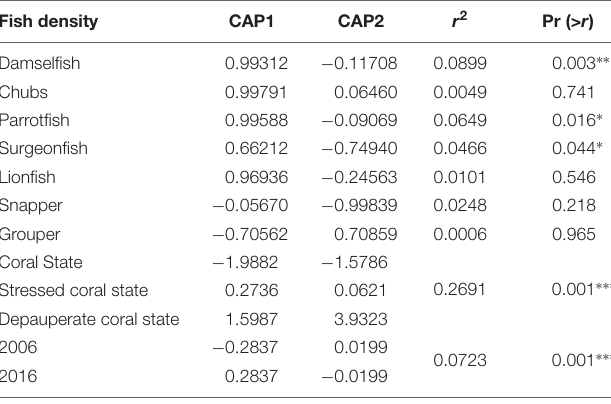
TABLE 4 | Results of the Canonical Analysis of Principal Coordinates used to correlate each key functional fish group with benthic variables. Fish density CAP1